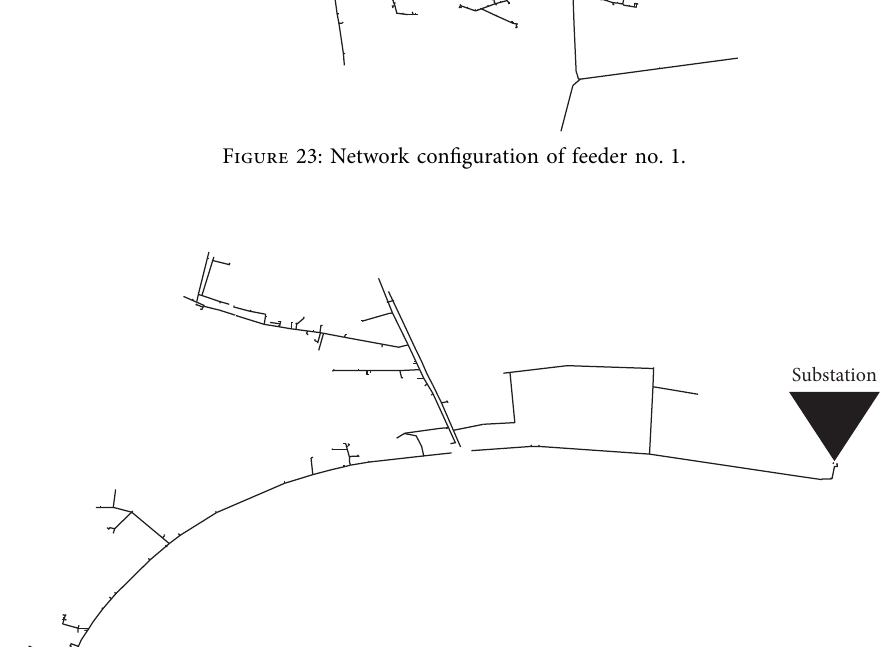
Figure 24: Network confguration of feeder no.